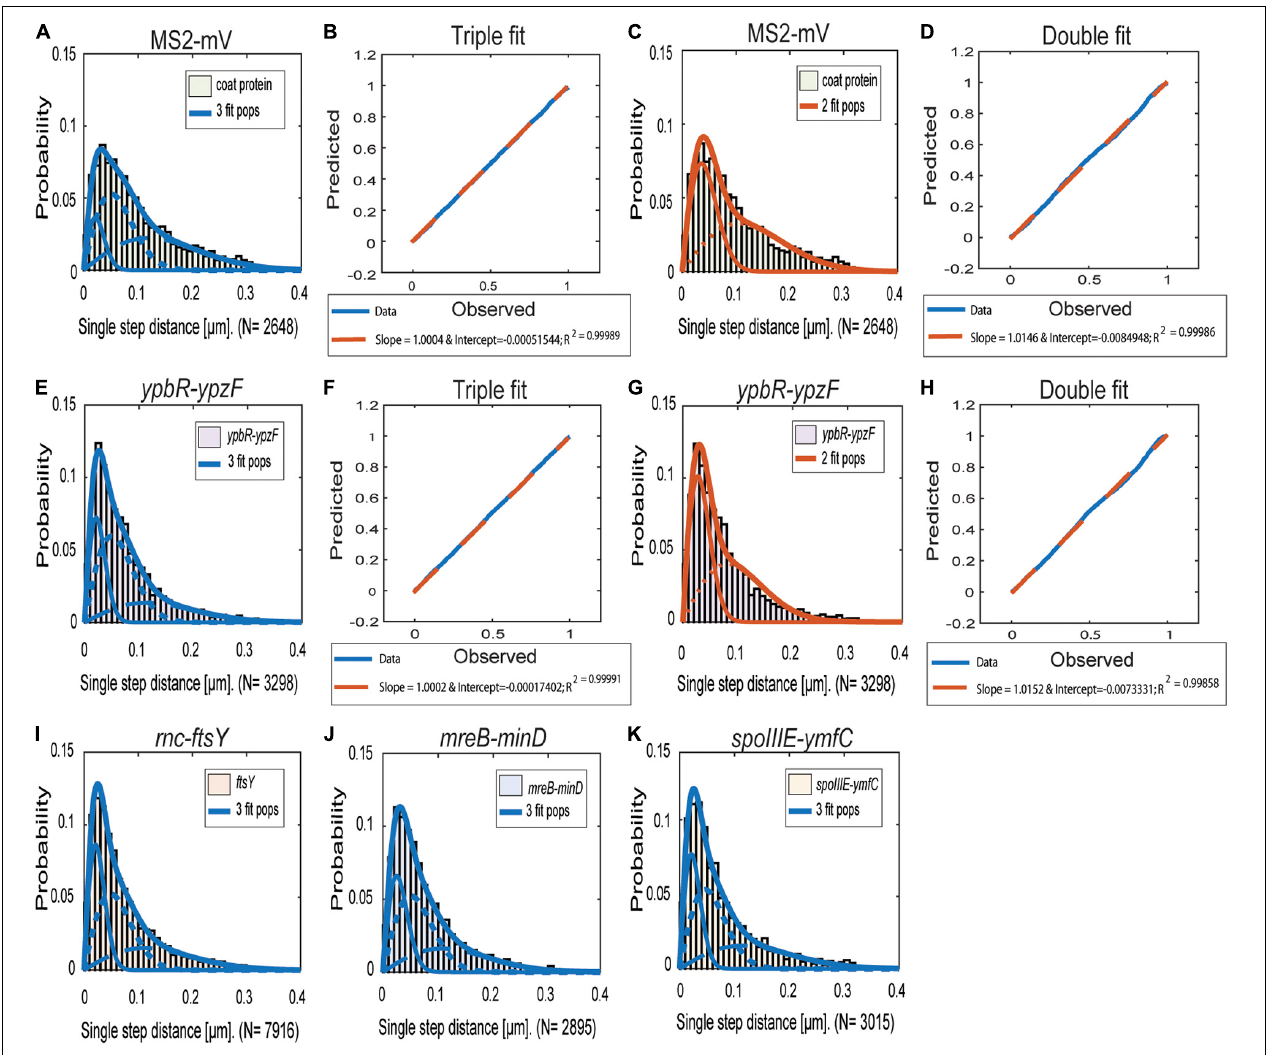
FIGURE 2 | Jump distance analyses of four MS2-tagged mRNAs. Triple fits are shown in blue; double fits in red. (A–D) , Cells expressing MS2-mVenus only. (E–K) Cells additionally containing MS2-binding sites fused to mRNAs. (E–H) MS2-mVenus + ypbR-ypzF (I) MS2-mVenus + ftsY _MS2–binding site 2 × , (J) MS2-mVenus + mreB-minD _MS2–binding site 2 × , and (K) MS2-mVenus + spoIIIE-ymfC _MS2–binding site 2 ×